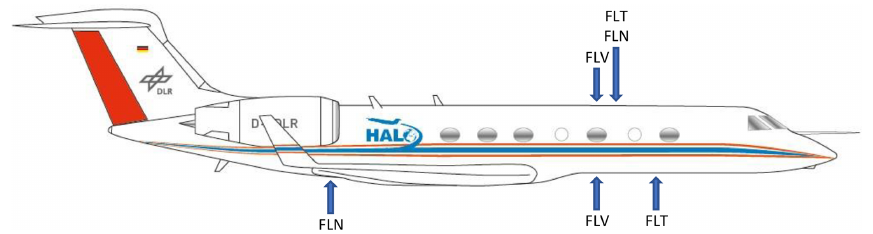
Figure 3. Top and bottom receiver positions of the three HALO configurations FLT, FLN and FLV. Adapted from a figure used with permis- sion from DLR,